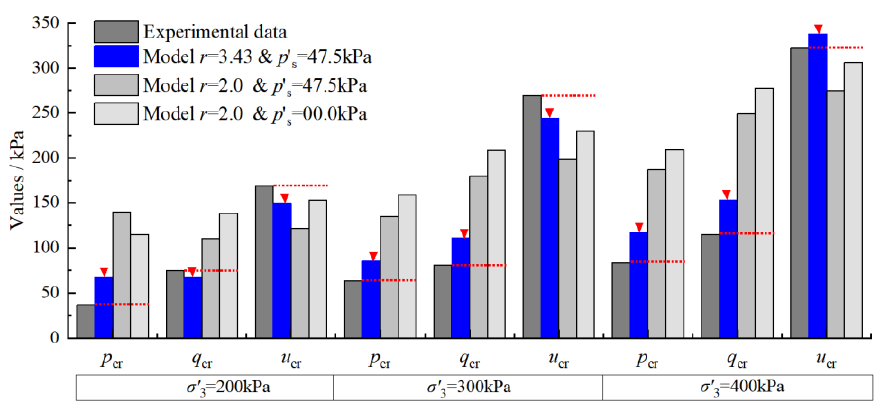
Figure 11. Comparisons between model prediction and test results: ( a ) stress-strain and pore pres- sure σ’ 3 = 200 kPa, ( b ) stress-strain and pore pressure σ’ 3 = 300 kPa, ( c ) stress-strain and pore pressure σ’ 3 = 400 kPa, ( d ) stress paths.